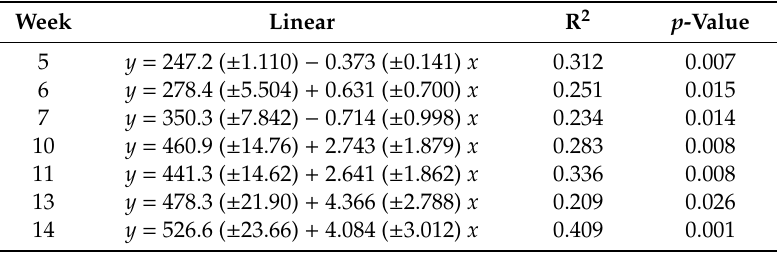
Table 3. Regression equations for average weekly feed intake of Boschveld indigenous hens in response to graded levels of seaweed